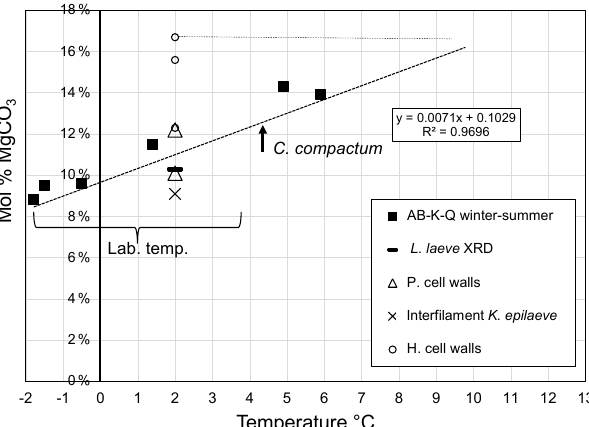
Figure 5. A range of SEM settings were used for imaging: sec- ondary (SE) electron showing topography, and backscatter electron imaging (BSE) which shows higher magnesium areas as darker car- bonate and is useful for rapid visual identification of mineral distri- bution. L. laeve and K. epilaeve Mg content relative to Clathromor- phum compactum from Arctic Bay, Kingitok, and Quirpon (Halfar et al., 2010, 2013). Lab – Labrador Sea. Heavy dashed line indicates best fit for C. compactum . Light dashed line indicates the tempera- ture equivalent on the C. compactum line for the L. laeve hypothal- lial Mg